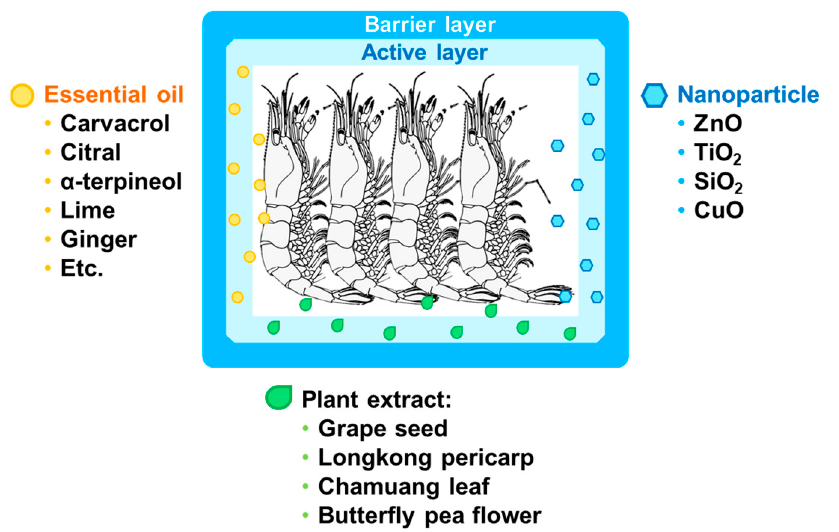
Figure 4. Active packaging with various active agents (essential oils, plant extracts, and nanoparti- cles) and its application for seafood